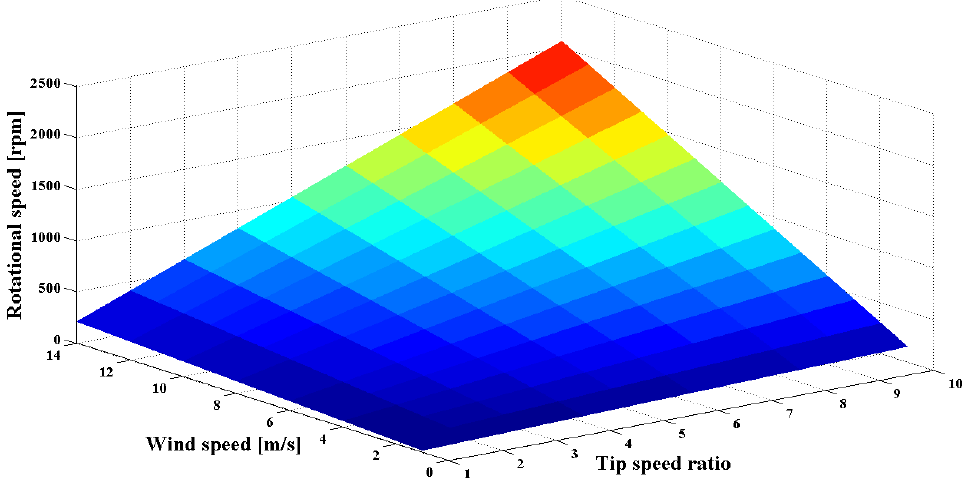
the radius of blade of 0.65